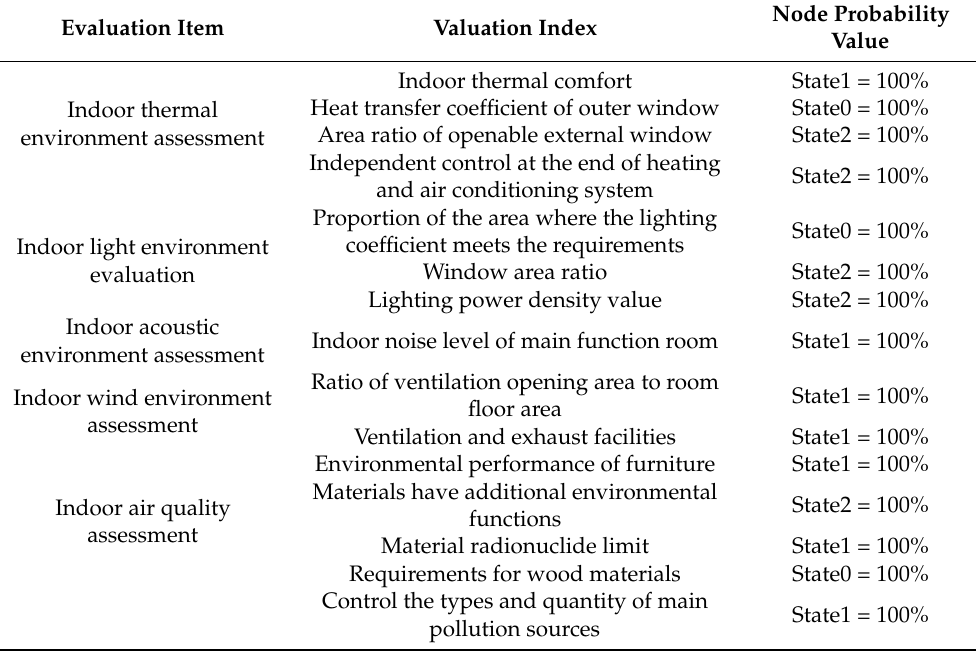
Table 2. Evaluation of indoor environmental quality.